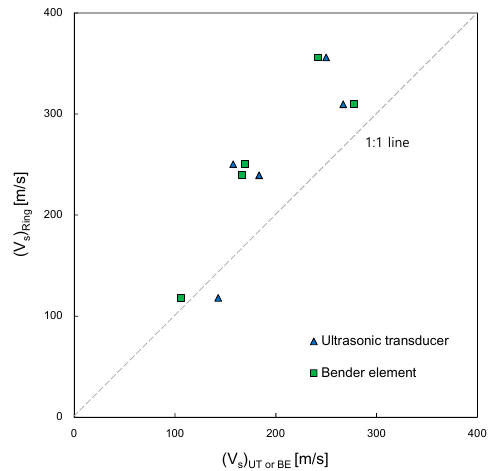
Figure 12. Comparison of shear wave velocities obtained from the ring bender with ultrasonic transducer and bender element.